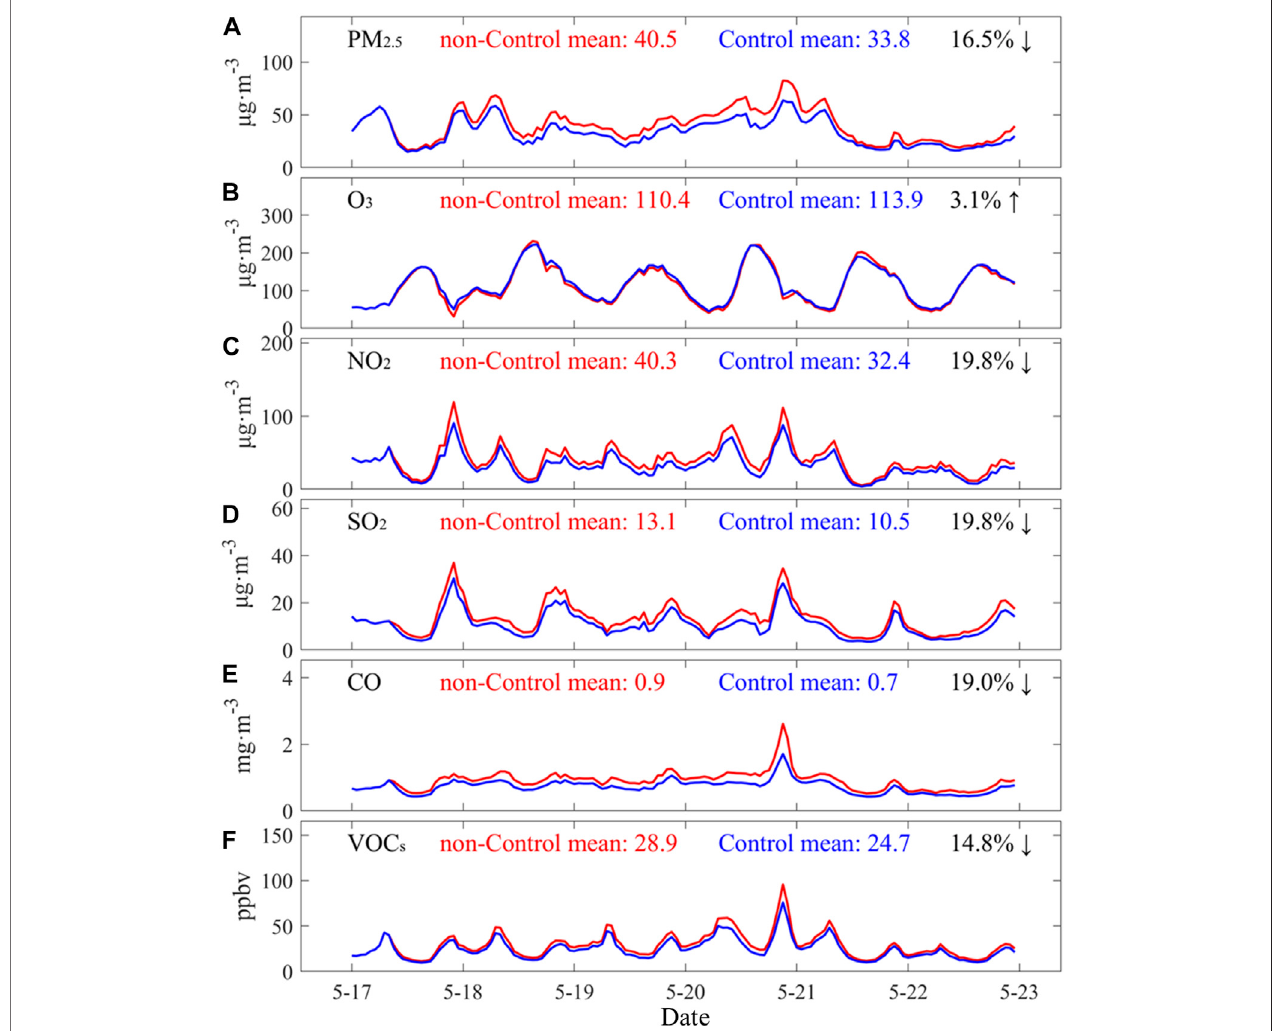
FIGURE 4 | The time series variations of simulated chemical species in control and non-Control scenario, including (A) PM 2.5 , (B) O 3 , (C) , NO 2 , (D) SO 2 , (E) CO 2 and (F) VOC s